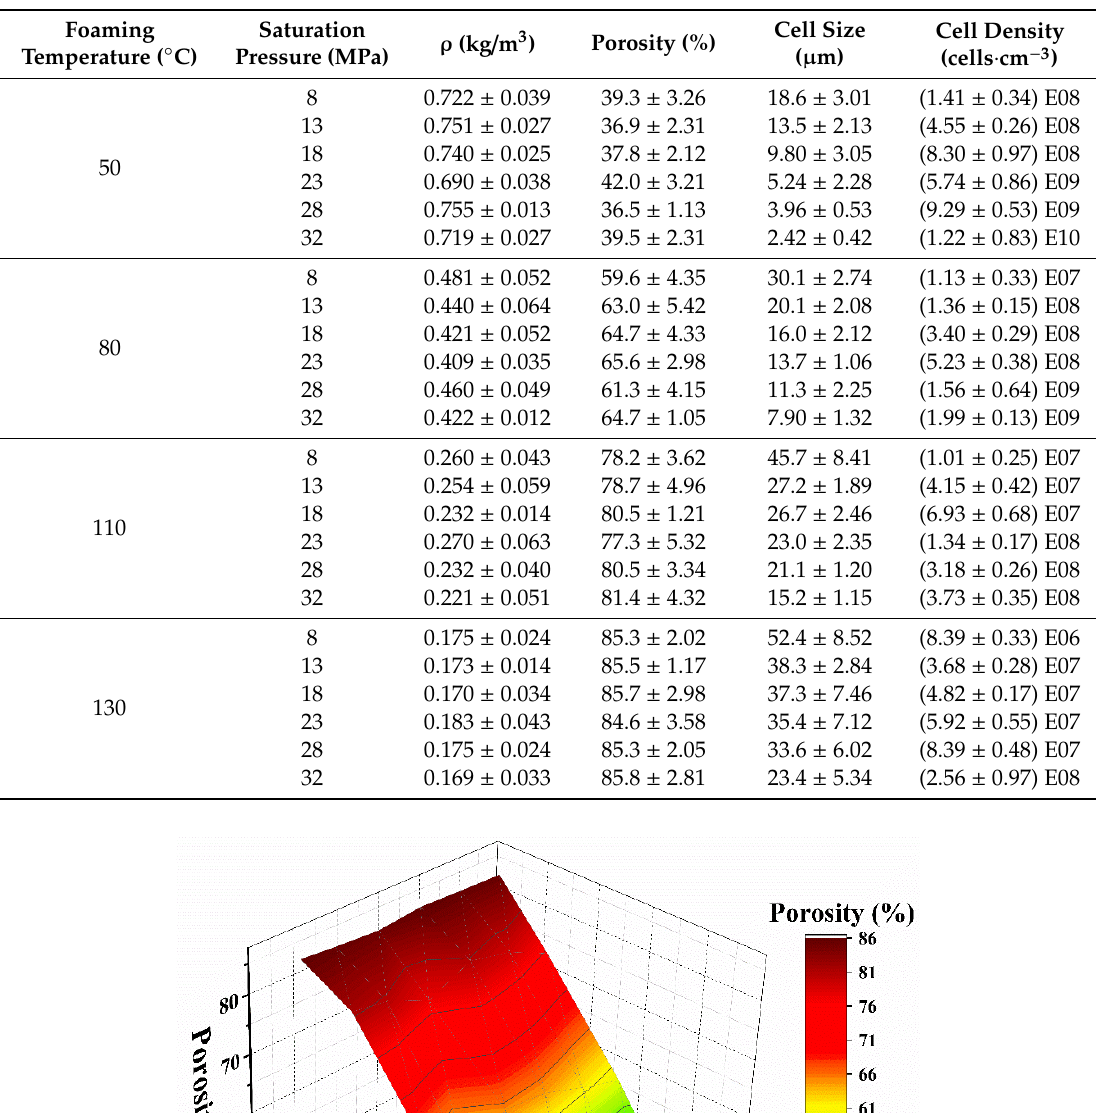
Table 1. Foam density, porosity, cell size and cell density results of samples at various foaming parameters.